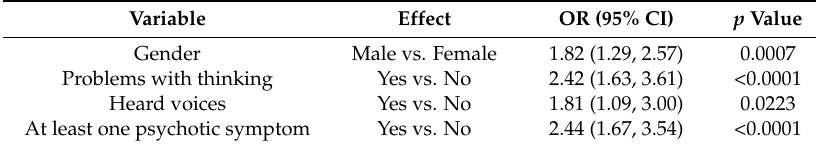
Table 3. Multiple logistic regression results among p-iRBD